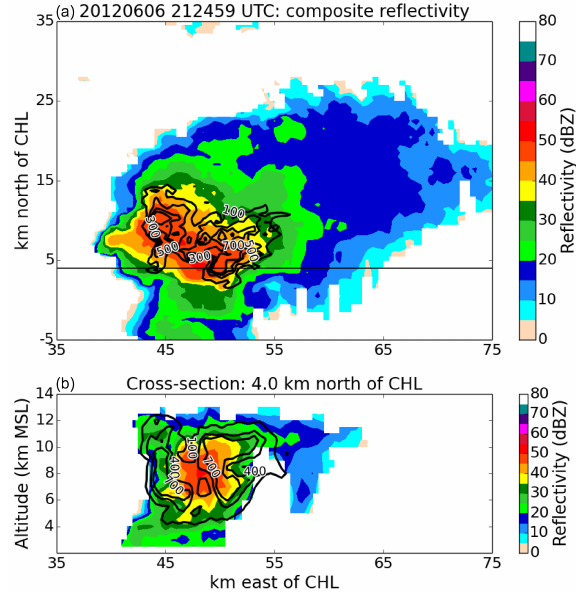
Figure 3. Two-panel plot of (a) composite radar reflectivity in plan view and (b) west–east cross-section through the 6 June 2012 case at 21:25. The radar reflectivity shown was retrieved by the CSU- CHILL radar. The position of the cross-section shown in (b) is in- dicated by the thin black horizontal line in (a) . The black contours superimposed on the radar reflectivity are (a) contours of vertically integrated LMA VHF source densities (b) LMA source densities horizontally integrated in the north–south direction. Contours in- dicate regions of frequent lightning discharges (large numbers of LMA-detected